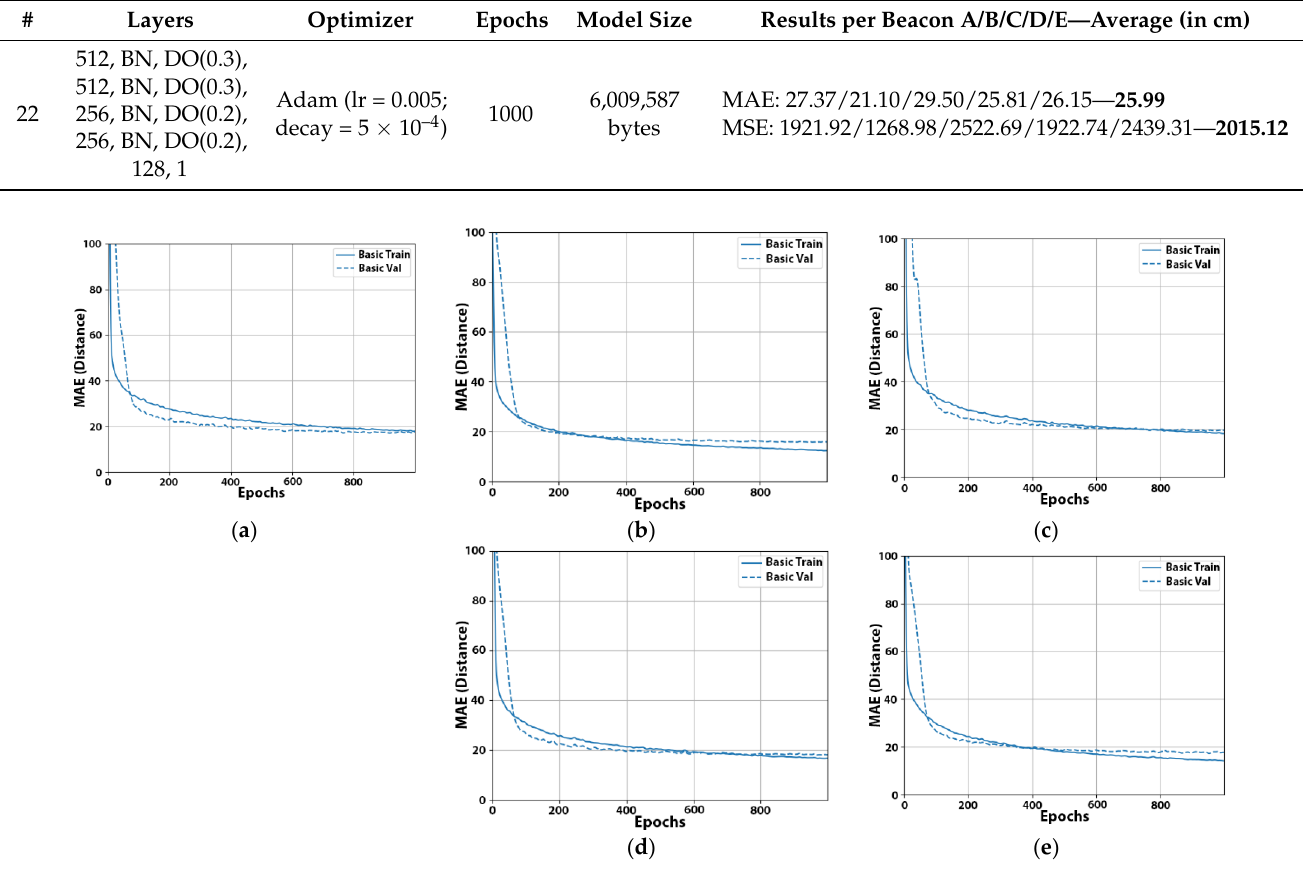
Figure 3. Learning curves of experiment No. 22 for beacons A ( a ), B ( b ), C ( c ), D ( d ), and E ( e ). Distances are expressed in cm.